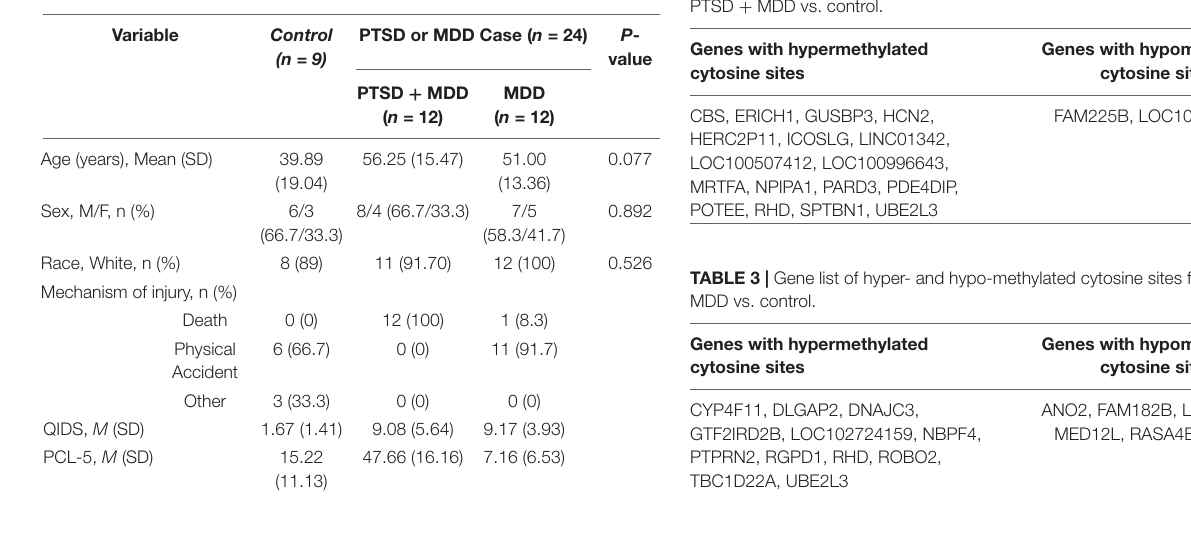
TABLE 1 | Characteristics of 33 patients hospitalized for trauma.